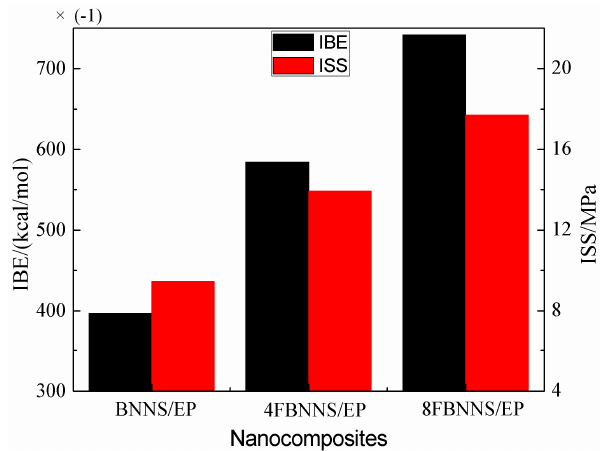
Figure 8. IBE (interfacial binding energy) and ISS (interfacial shear strength) of BNNS / EP nanocomposites.